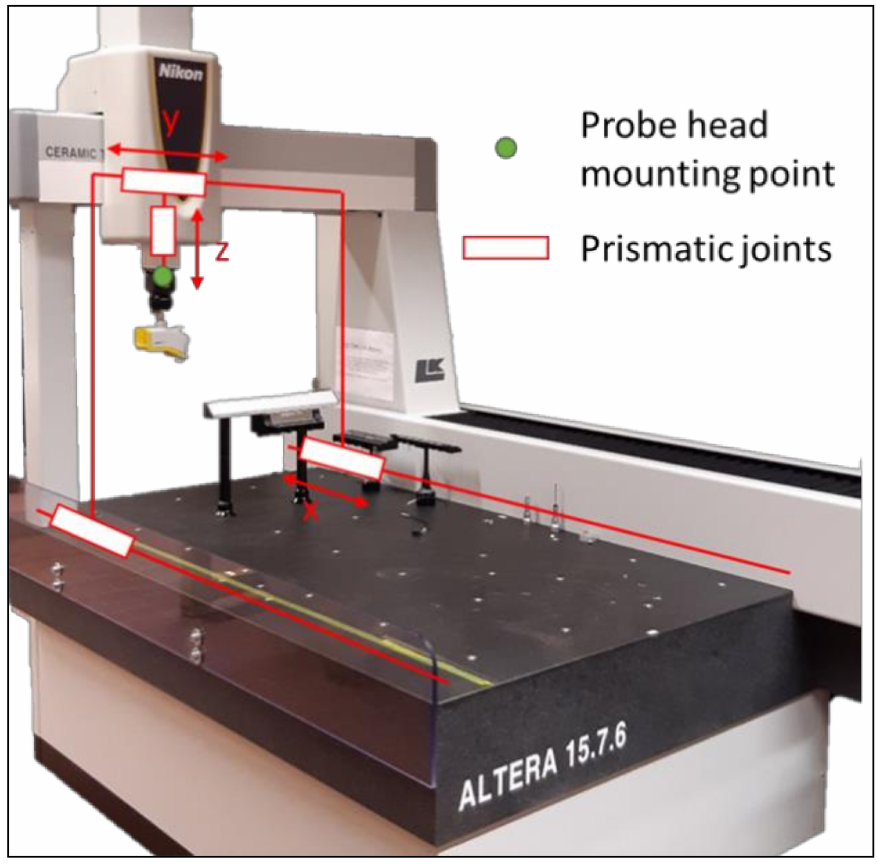
Figure 1. A CMM with the prismatic joints which allows three translation movements of the phmp along the axis of movement. X, Y and Z denote the linear